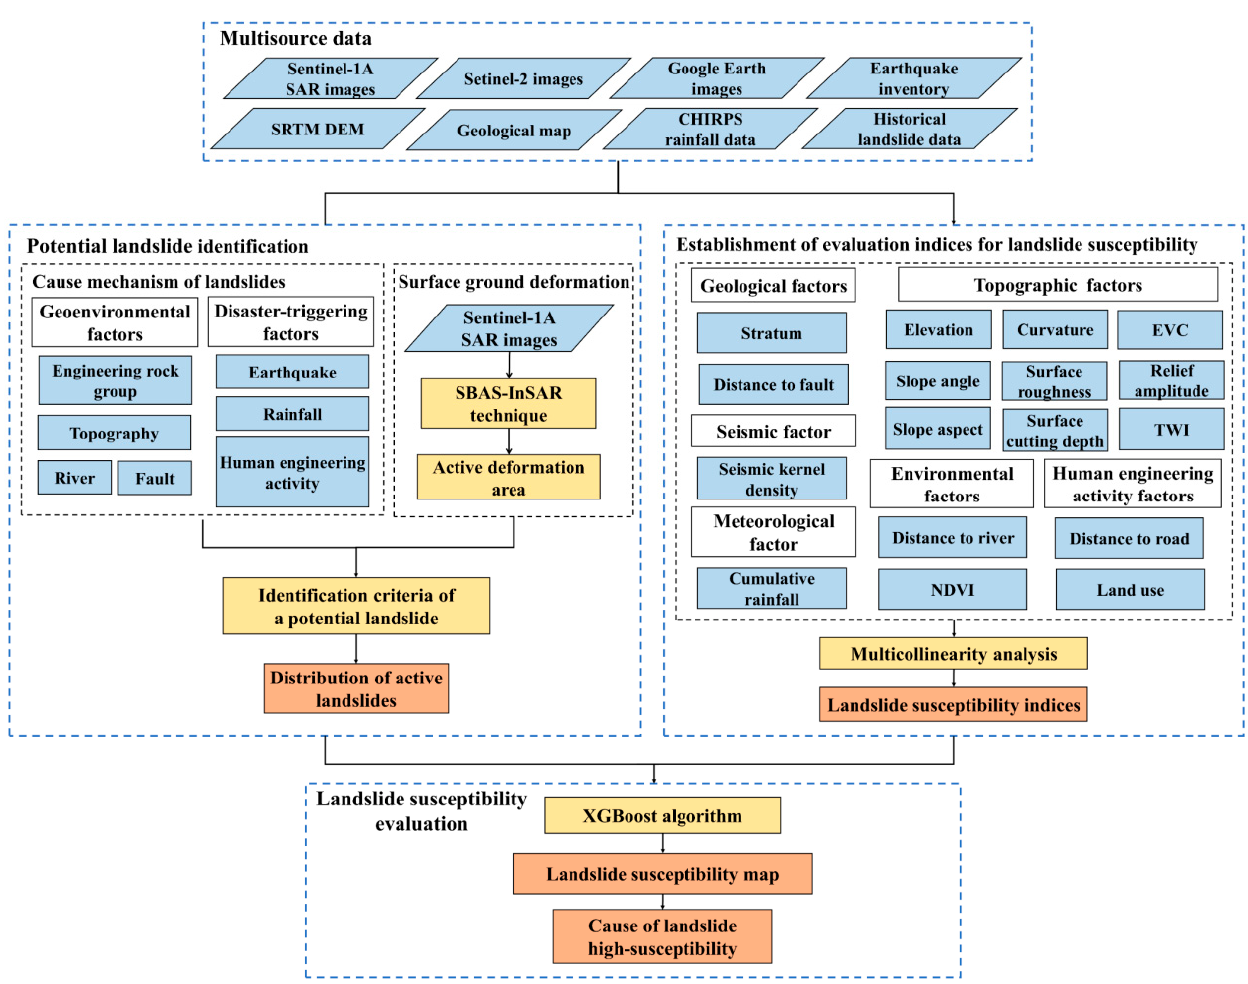
Figure 2. Technical route of potential landslide identification and landslide susceptibility evalua- tion.